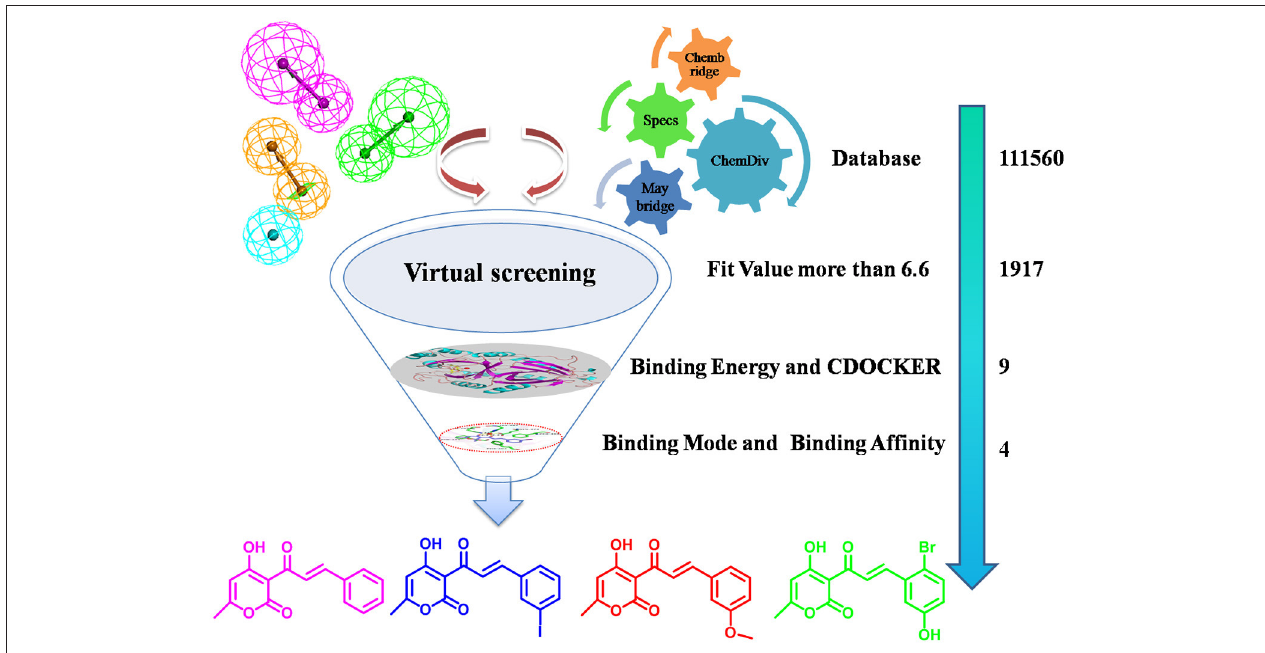
FIGURE 1 | The screening workflow that was applied to discern novel HPPD